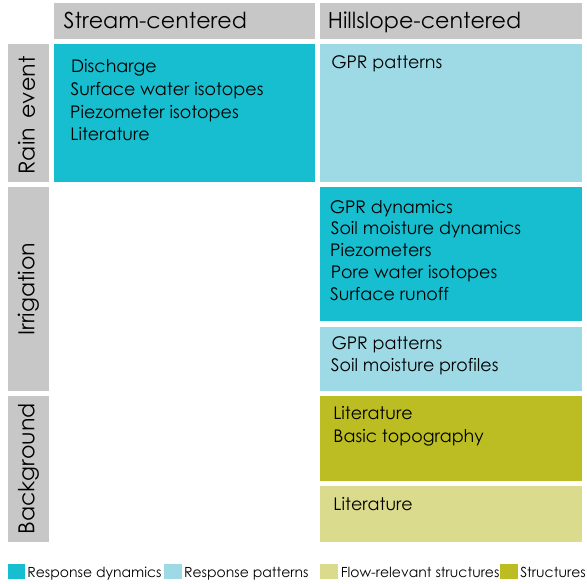
Figure 3. Experimental methods applied in the stream-centered and hillslope-centered approaches, divided into the sampling during the natural rain event and the irrigation experiment. Additionally, some structural background information was obtained from the literature and a digital elevation